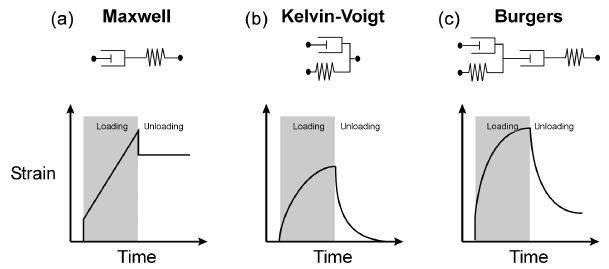
Figure 11. Rheological models represented as spring and dashpots under loading and unloading with their relative strain–time curve: (a) Maxwell model; (b) Kelvin–Voigt model; (c) Burgers model. See text for